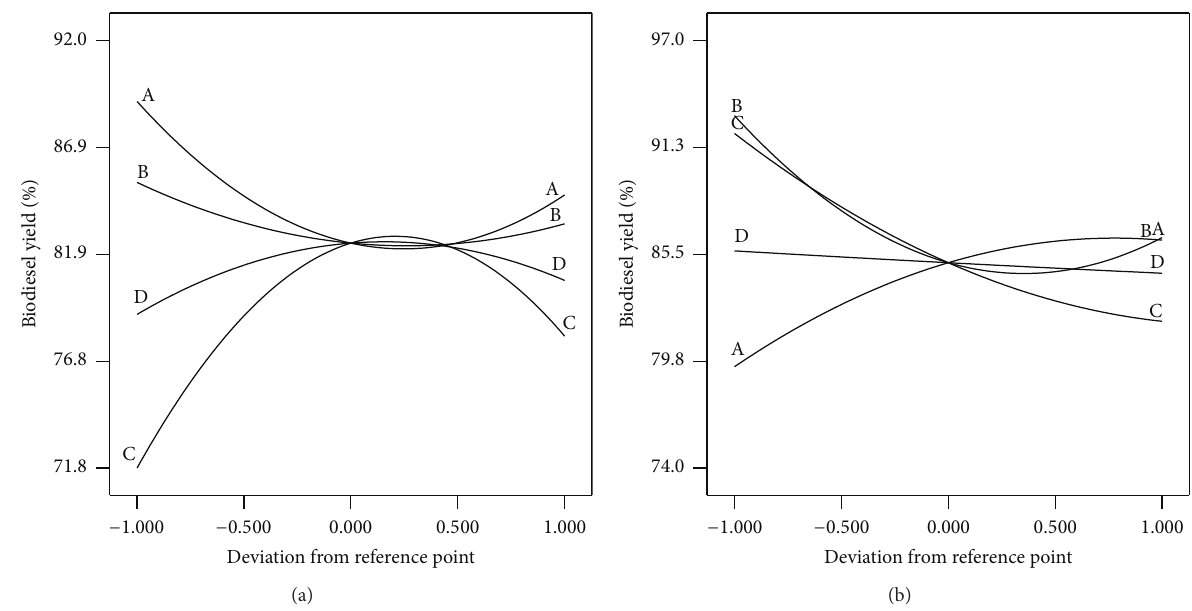
Figure 9: Perturbation plot for biodiesel yield in case of mollusks (a) and crabs (b)